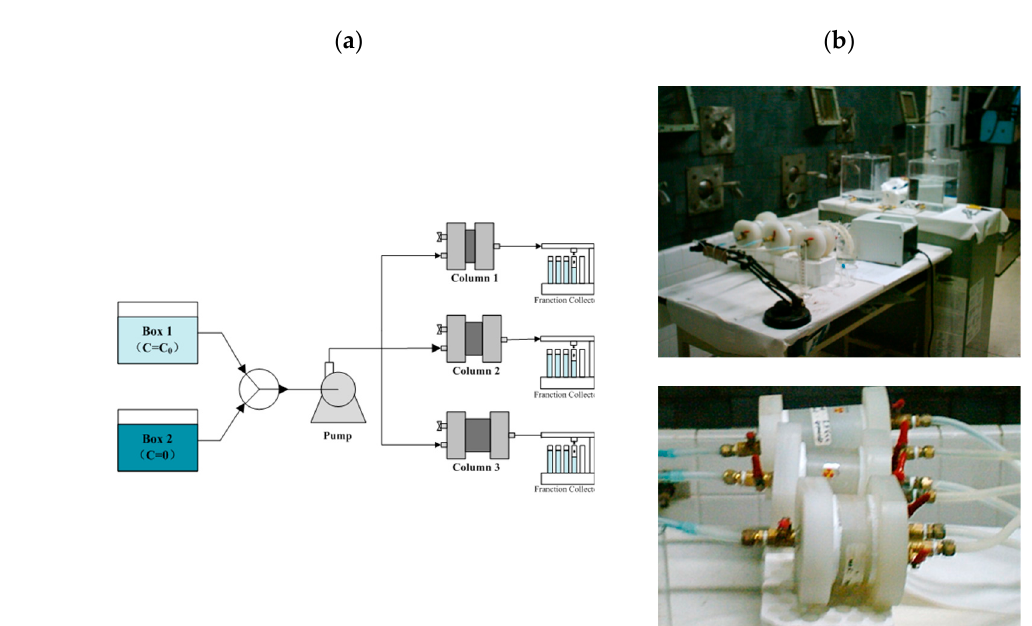
Figure 1. A reliable, precise ADE device with a PP (poly-propane) column apparatus used in this study. ( a ) schematic apparatus; ( b ) experimental